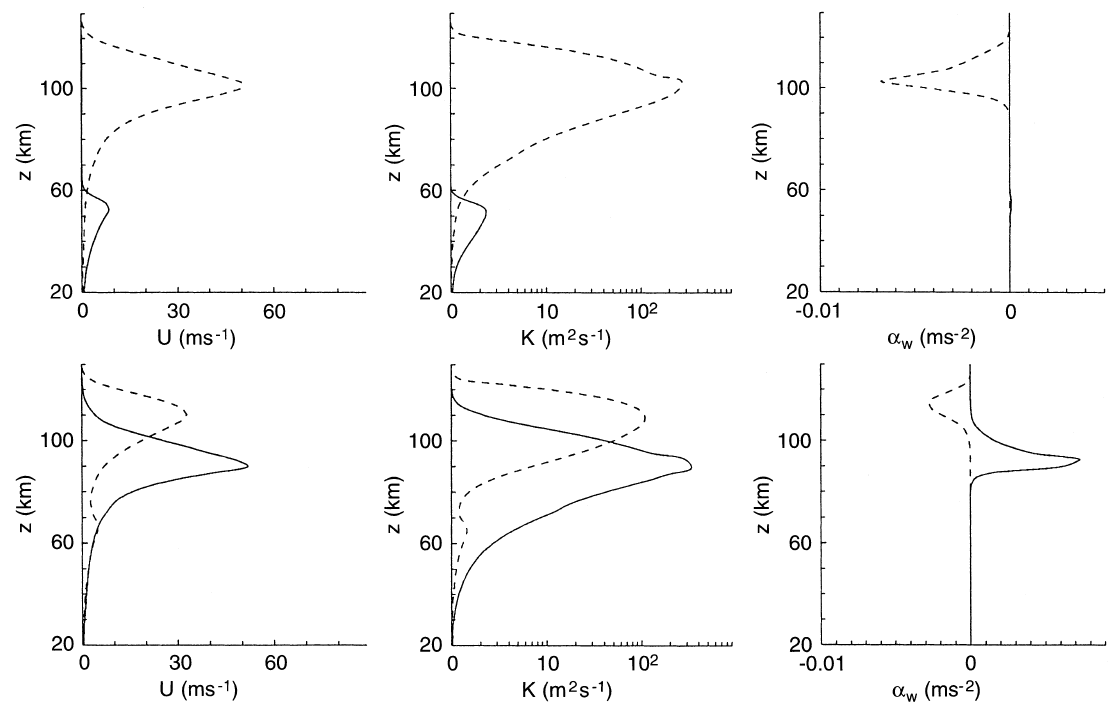
Fig. 5. Same as Fig. 4, but for IGWs with j c j (cid:136) 60m s (cid:255)